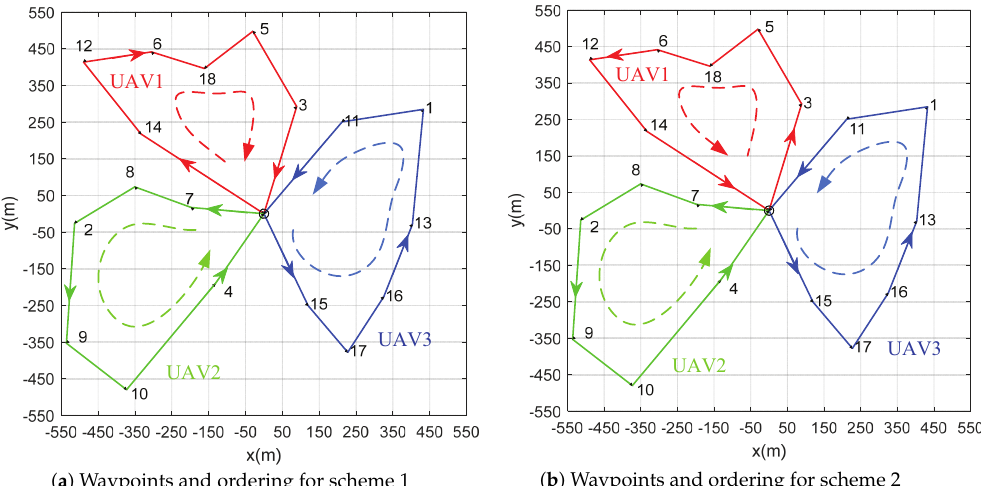
Figure 3. Illustration of the differences in the results of the modified genetic algorithm with two trajectory initializations: ( a ) The results with an initialization of the trajectories and visiting orders for the three UAVs in which two UAVs travel in the anticlockwise direction; ( b ) The results with another initialization of the scheme in which all UAVs travel in the anticlockwise